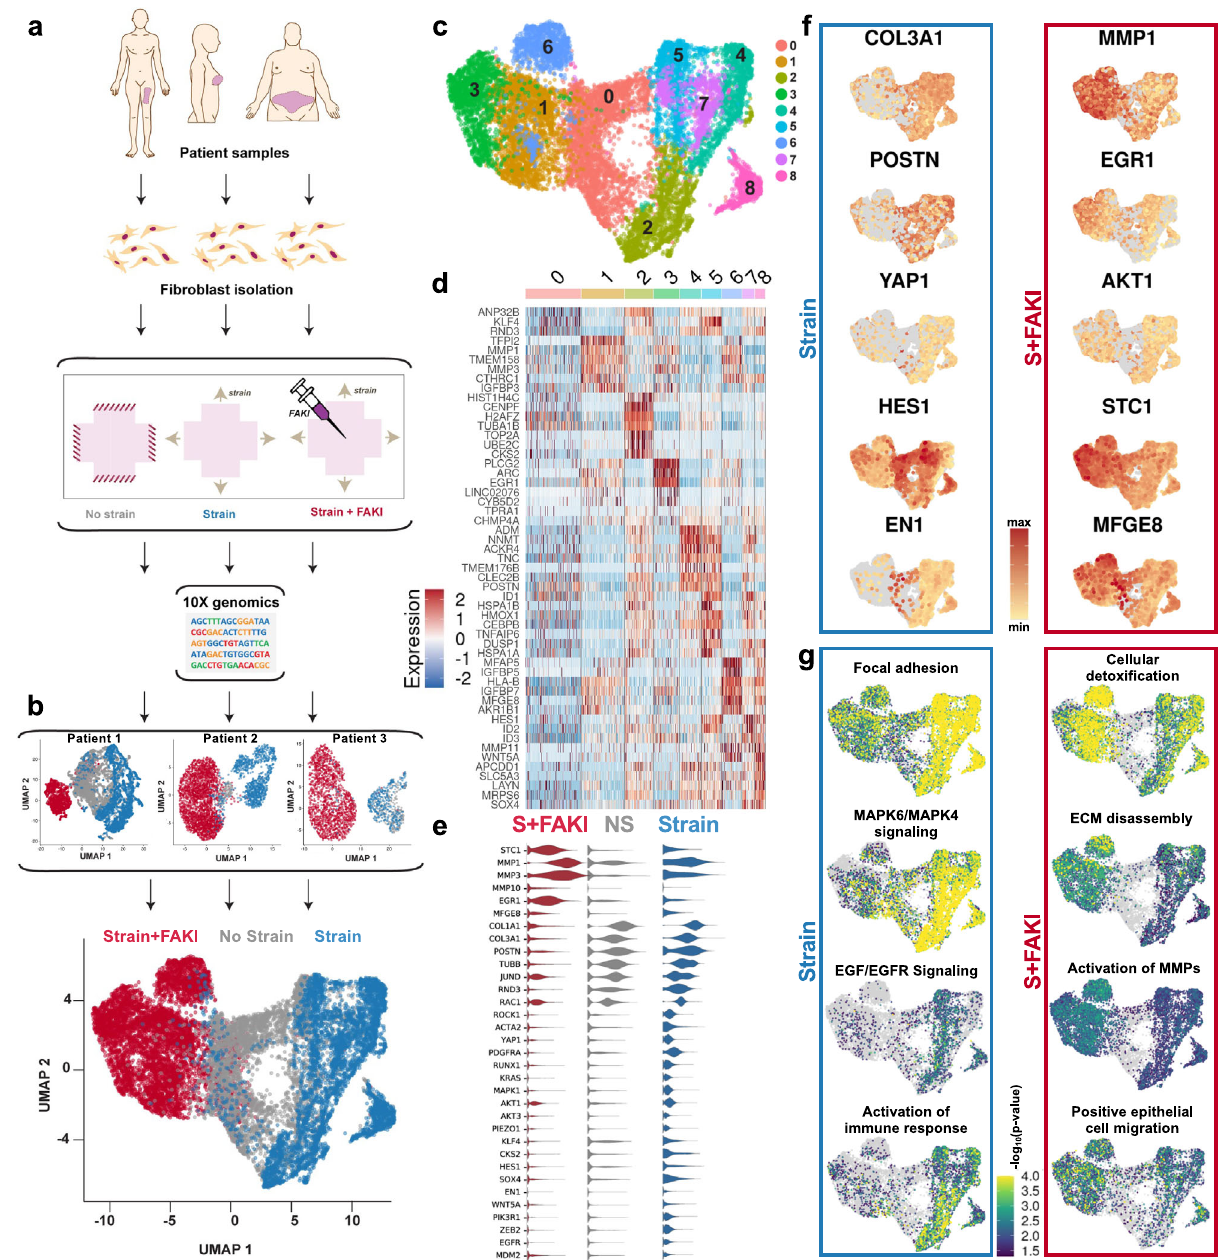
Fig. 4 Mechanical stress drives pro fi brotic fi broblast heterogeneity; subsequent inhibition of mechanotransduction reduces heterogeneity and triggers AKT-dependent EGR1 and MFGE8 expression. a Adult human dermal fi broblasts were isolated from tissue collected from three patients at different anatomical locations: the breast skin from a mastectomy sample, the abdomen skin from an abdominoplasty sample, and the thigh skin from a thighplasty sample. Freshly isolated fi broblasts were seeded into 3D collagen scaffolds and subjected to either no strain (NS, gray), strain (S, blue), or strain + 10 μ M FAKI (S + FAKI, red) and then submitted for 10× genomics. b UMAP embeddings of cellular transcription pro fi les for the three patients were combined into a fi nal embedding. c Unsupervised clustering of fi broblast transcriptional signatures revealed a total of 9 distinct clusters of human dermal fi broblasts (clusters 0 – 8). d Heatmap of the top fi ve differentially expressed genes in all clusters. e Violin plots of group-de fi ning differentially expressed genes. f Gene expression of group-de fi ning genes projected onto UMAP embedding. g Over-representation analysis (ORA) of key pathways that differentiate the groups projected onto UMAP proin fl ammatory myo fi broblast clusters. Instead, we found that (Fig. 4e, f, Supplementary Fig. 3a-c). MMPs reduce fi brosis across disruption of FAK signaling shifted fi broblasts toward a more a wide range of disease models through collagen homogeneous metastate (Fig. 4b, c). We observed that blocking degradation 53 – 55 , and also promote cellular migration and re- mechanical signaling strongly reduced the transcription of epithelialization 53,56 . Finally, FAK inhibition induced the expres- sion of the anti fi brotic gene STC1 (stanniocalcin-1), which has collagen encoding genes, such as COL1A1 and COL3A1 (Fig. 4e, also been shown to promote wound healing and re- f), and strongly induced the expression of the matrix- epithelialization 57,58 . metalloproteinase (MMP) genes MMP1, MMP3 , and MMP10